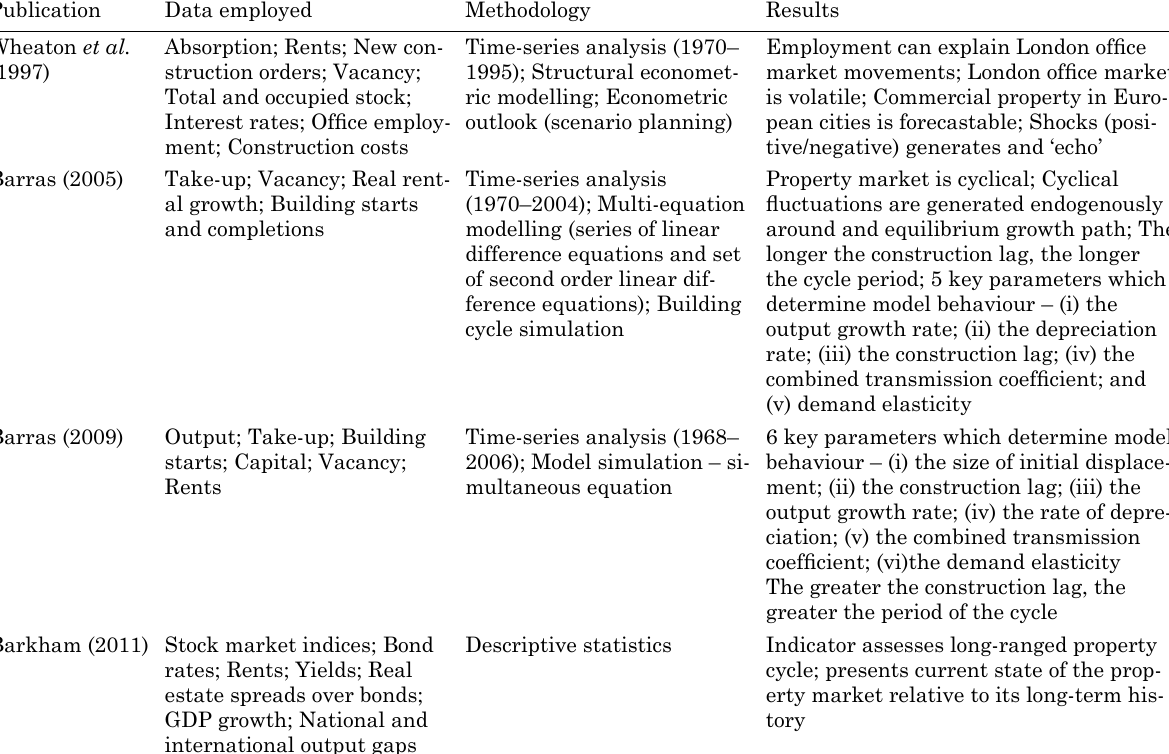
table 5. Key ‘modern’ publications on property